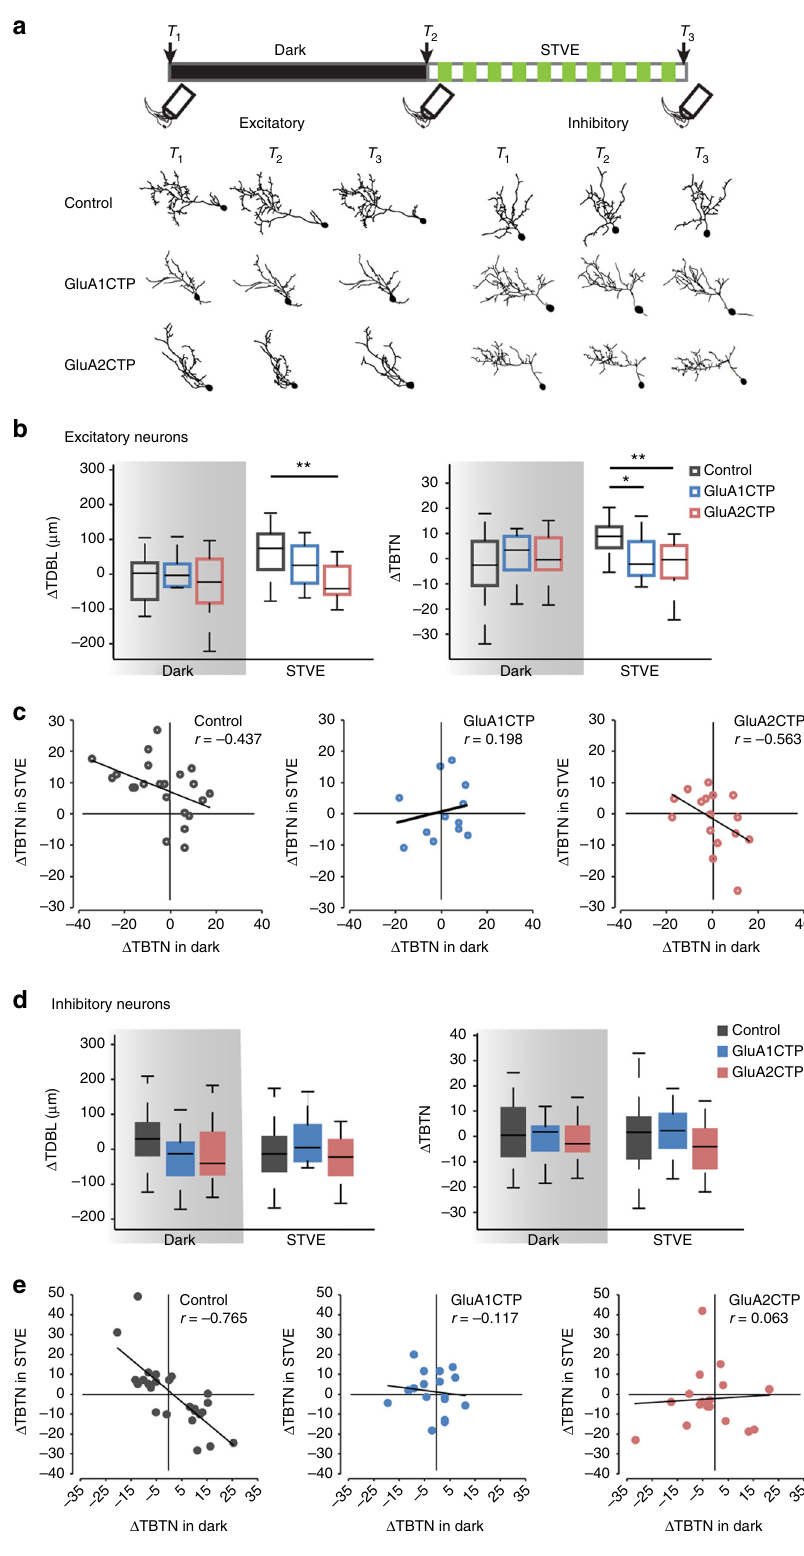
Fig. 4 GluACTP expression disrupts experience-dependent structural plasticity in excitatory and inhibitory neurons. a Representative images of complete dendritic arbor reconstructions from time-lapse images taken before ( T 1 ) and after ( T 2 ) 4 h of dark, and after 4 h of STVE ( T 3 ) of individual excitatory and inhibitory neurons in each group. Top: schematic shows the experimental protocol and imaging time course. b Summary data of changes in TDBL ( Δ TDBL) and TBTN ( Δ TBTN) during the dark and STVE periods in excitatory neurons. GluA1CTP and GluA2CTP signi fi cantly decrease STVE-induced dendritic arbor growth. * P < 0.05, ** P < 0.01, Kruskal – Wallis test with post hoc Mann – Whitney U test. c Scatter plots of Δ TBTN in response to STVE versus dark in individual excitatory neurons. Rho value of Pearson correlation is shown on each plot. d Summary data of Δ TDBL and Δ TBTN during dark and STVE periods in inhibitory neurons. e Scatter plots of Δ TBTN in response to STVE versus dark in individual inhibitory